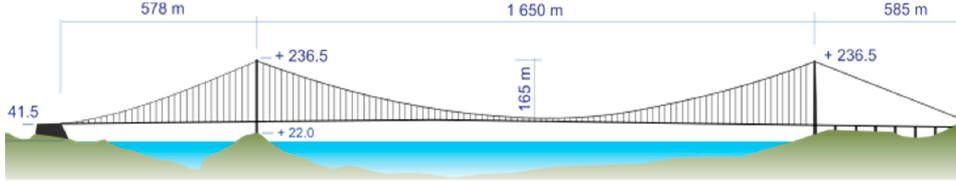
Figure 10. Elevation of XHM Bridge.